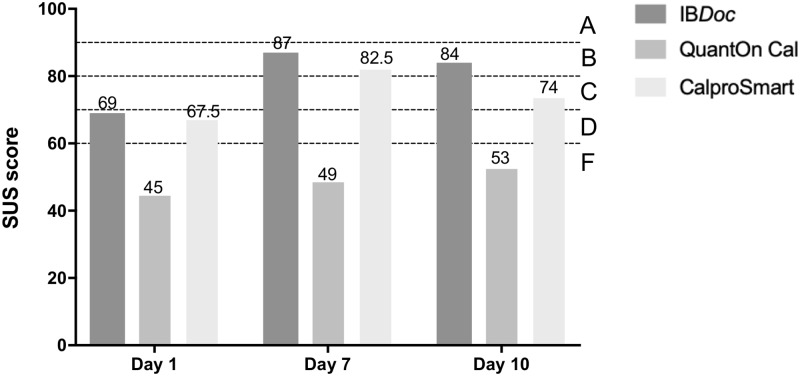
Student’s mean system usability scale (SUS) scores on day 1, 7 and day 10 of testing.SUS scores above 90 should be converted to “A”; 80–90 to “B”; 70–80 to “C”; 60–70 to “D”; and below 60 to “F”.